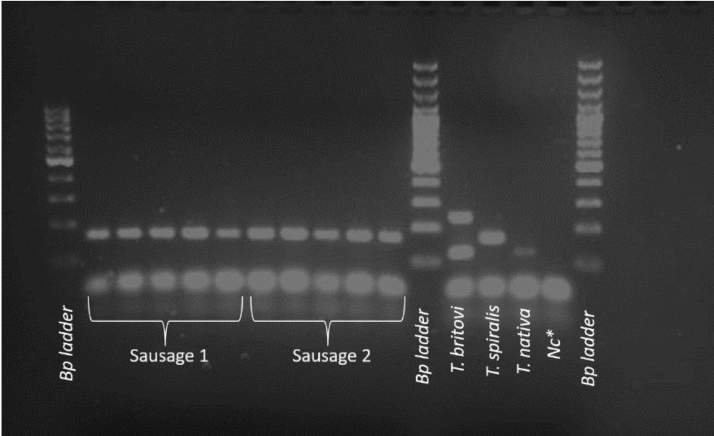
Figure 2. PCR identification of Trichinella spp. detected in raw Polish sausage. Samples on patterns marked as Sausage 1 and Sausage 2 (173 bp) have been identified as T. spiralis . Positive controls: T. britovi , T. spiralis , T. nativa ; Nc*—negative control (H 2